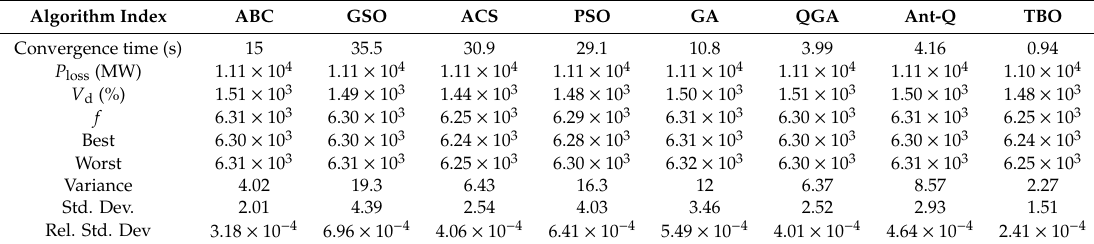
based Q-learning